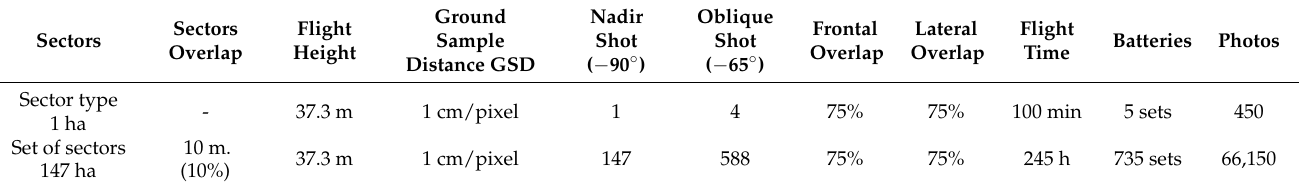
Table 6. Summary of UAV photogrammetry capture